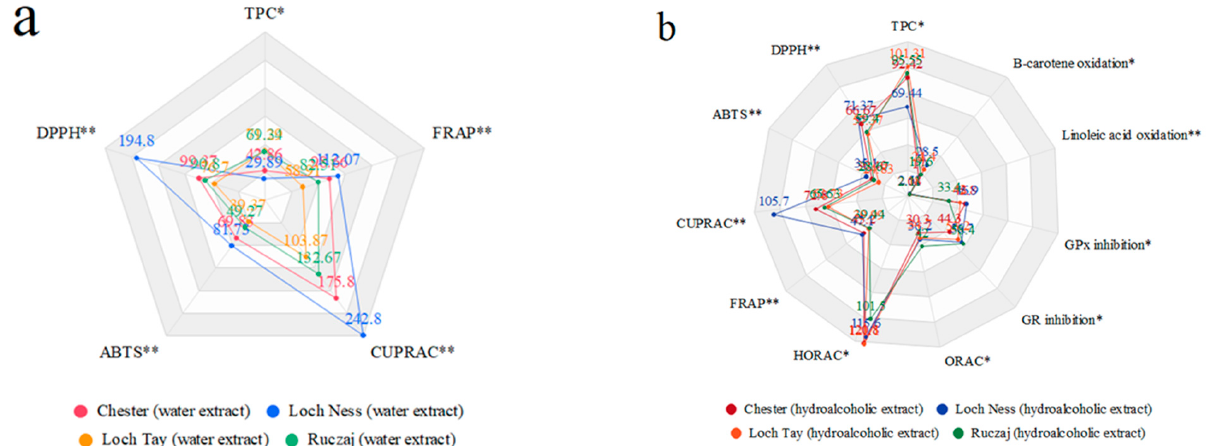
Figure 2. TPC in correlation with summarized antioxidant activity of blackberry leaves water ( a ) and hydroalcoholic ( b ) extracts. * the higher the value, the higher the activity. ** the lower the value, the higher the activity.